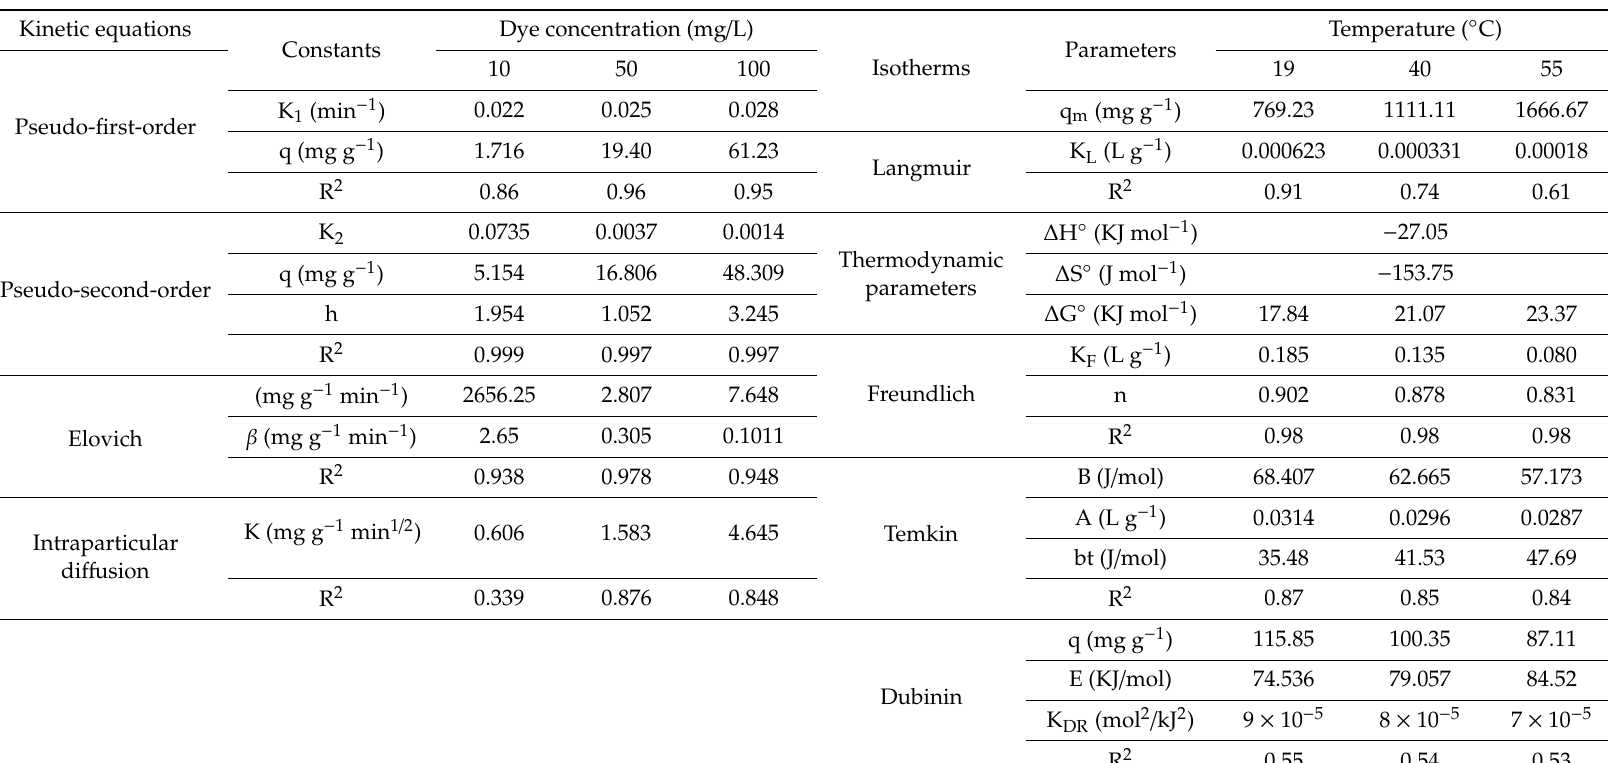
Table 2. Summarized kinetic constants, Langmuir, Freundlich, Temkin, and Dubinin parameters for the adsorption of methylene blue using powdered fruit derived from Nerium oleander